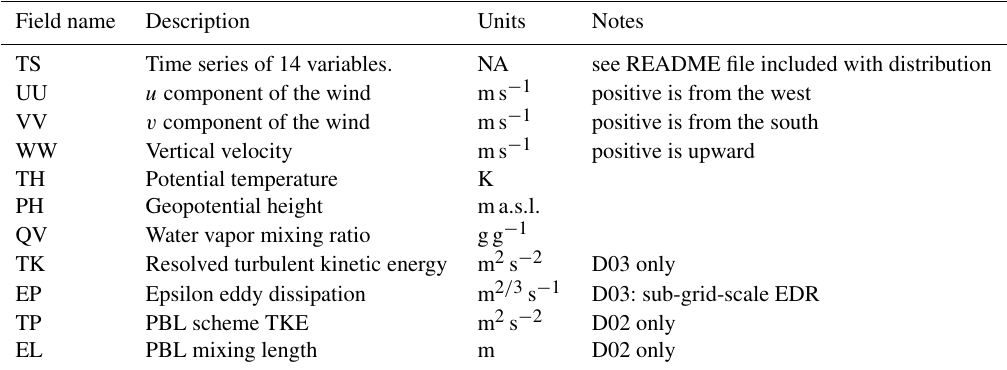
Figure 7. Time–height plots depicting evolution of wind speed and vertical velocity from (a, d) WRF LES and (b, e) University of Colorado Doppler lidar at Saguache Municipal Airport on 19 July 2018. The bottom row of plots provides distributions of (c) wind speed and (f) vertical velocity from WRF LES (red) and Doppler lidar (black) using 10s data for two time periods (08:00–10:00 and 10:00–12:00MDT) using all samples obtained between 40 and 140ma.g.l. Table 4. Description of variables stored for point locations in ASCII